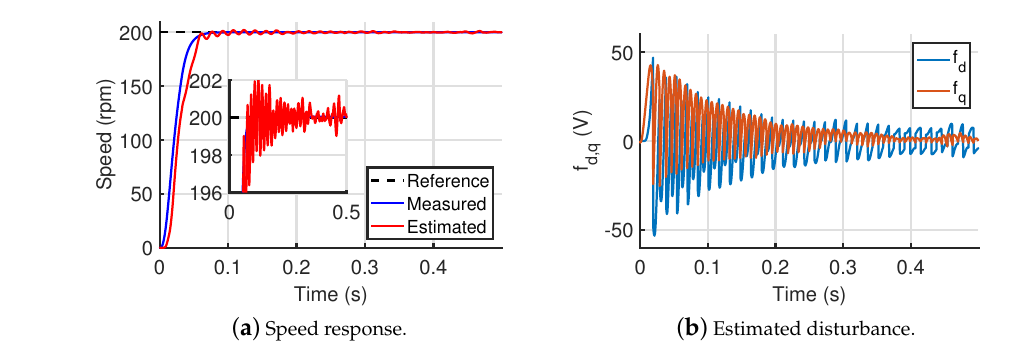
Figure 7. Simulation results under R = 10 R 0